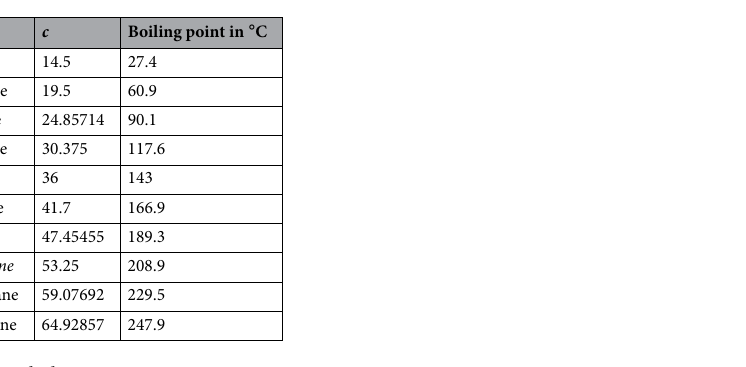
Table 4. Data for 8, 2-methyl